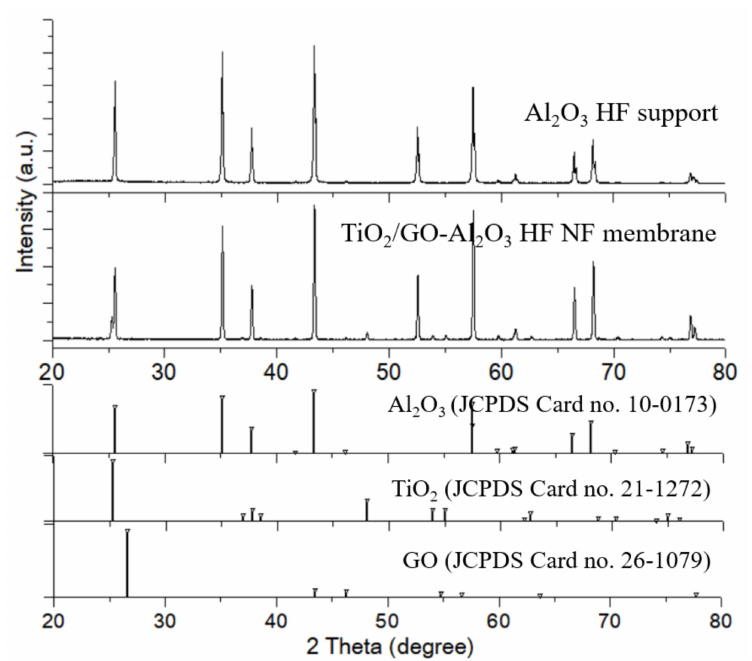
Figure 4. XRD of the Al 2 O 3 HF support and TiO 2 /GO-Al 2 O 3 HF NF membrane, along with standard XRD pattern of graphite for Al 2 O 3 (JCPDS Card No. 10-0173), TiO 2 (JCPDS Card No. 21-1272) and graphite (JCPDS Card no. 26-1079) for